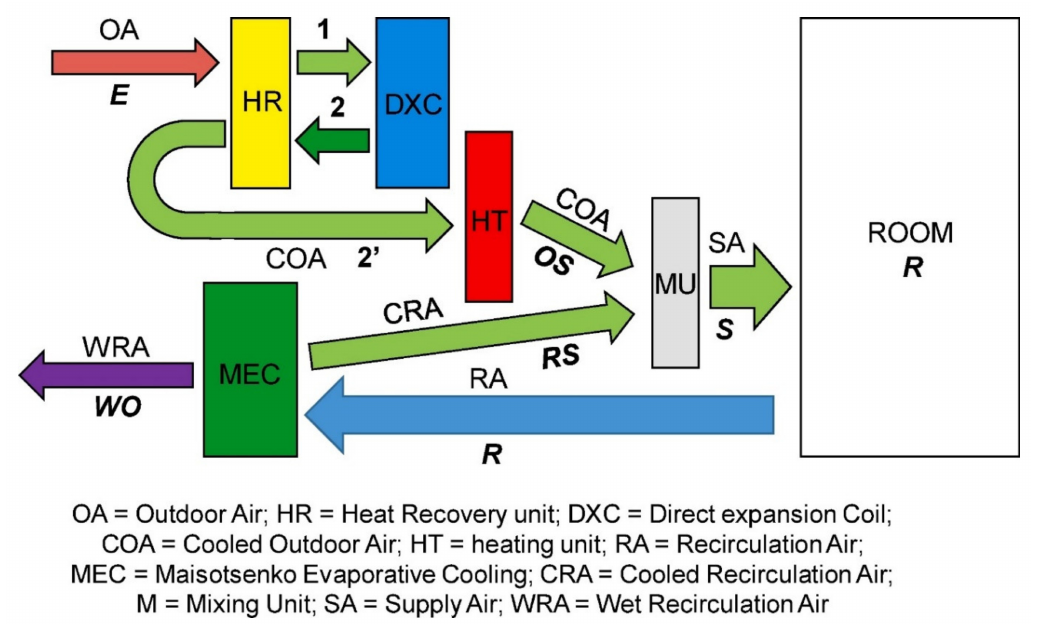
Figure 10. Hybrid RIEC-MVC system using RIEC to treat recirculated air. Reprinted with permission from Ref. [56]. Copyright 2019,